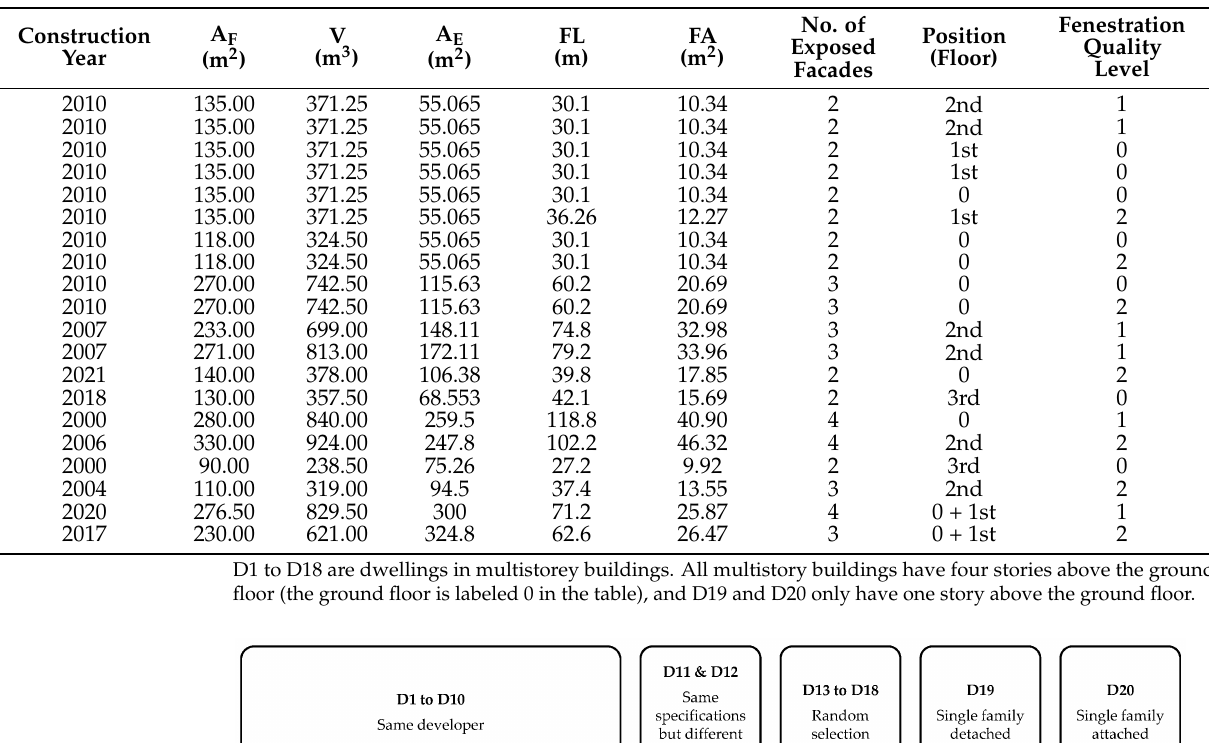
Table 2. Details of the tested dwellings.